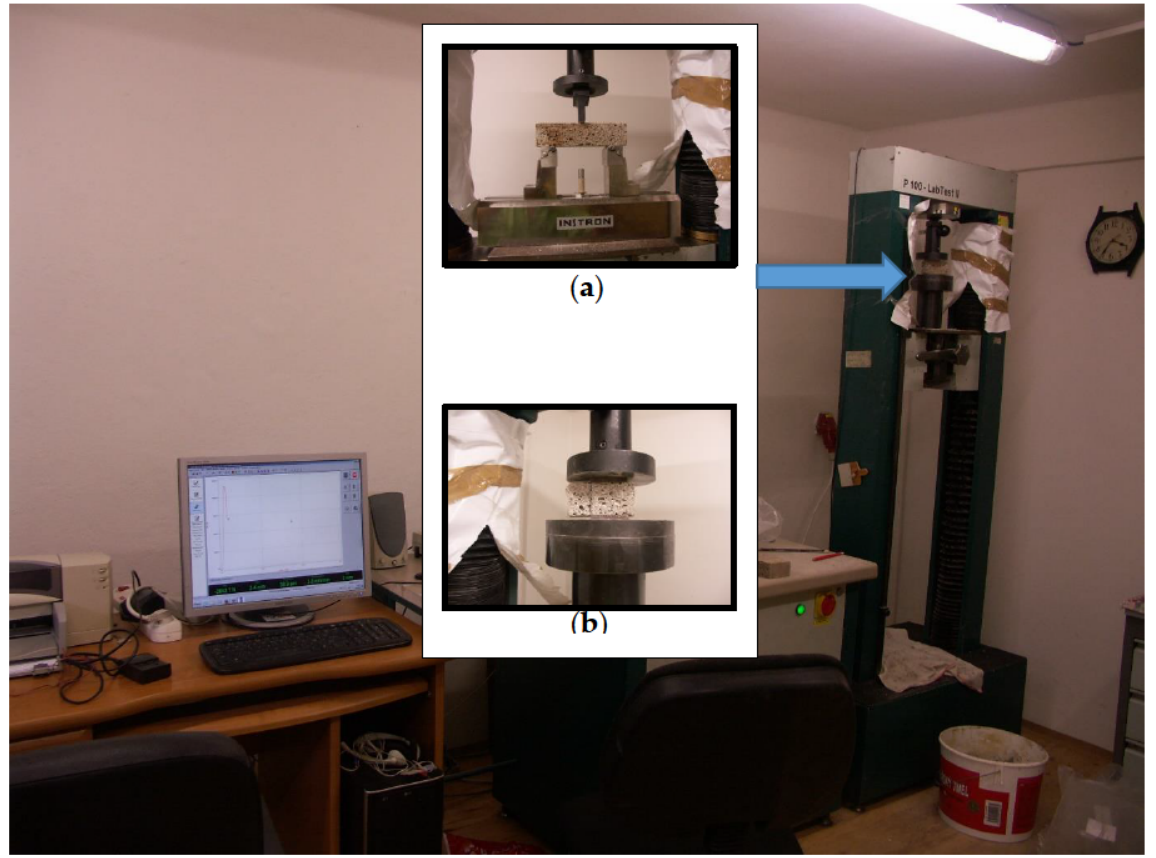
Figure 5: Universal testing machine INSTRON (Model 4202): a) test set-up for flexural strength b) test set-up for compressive strength.